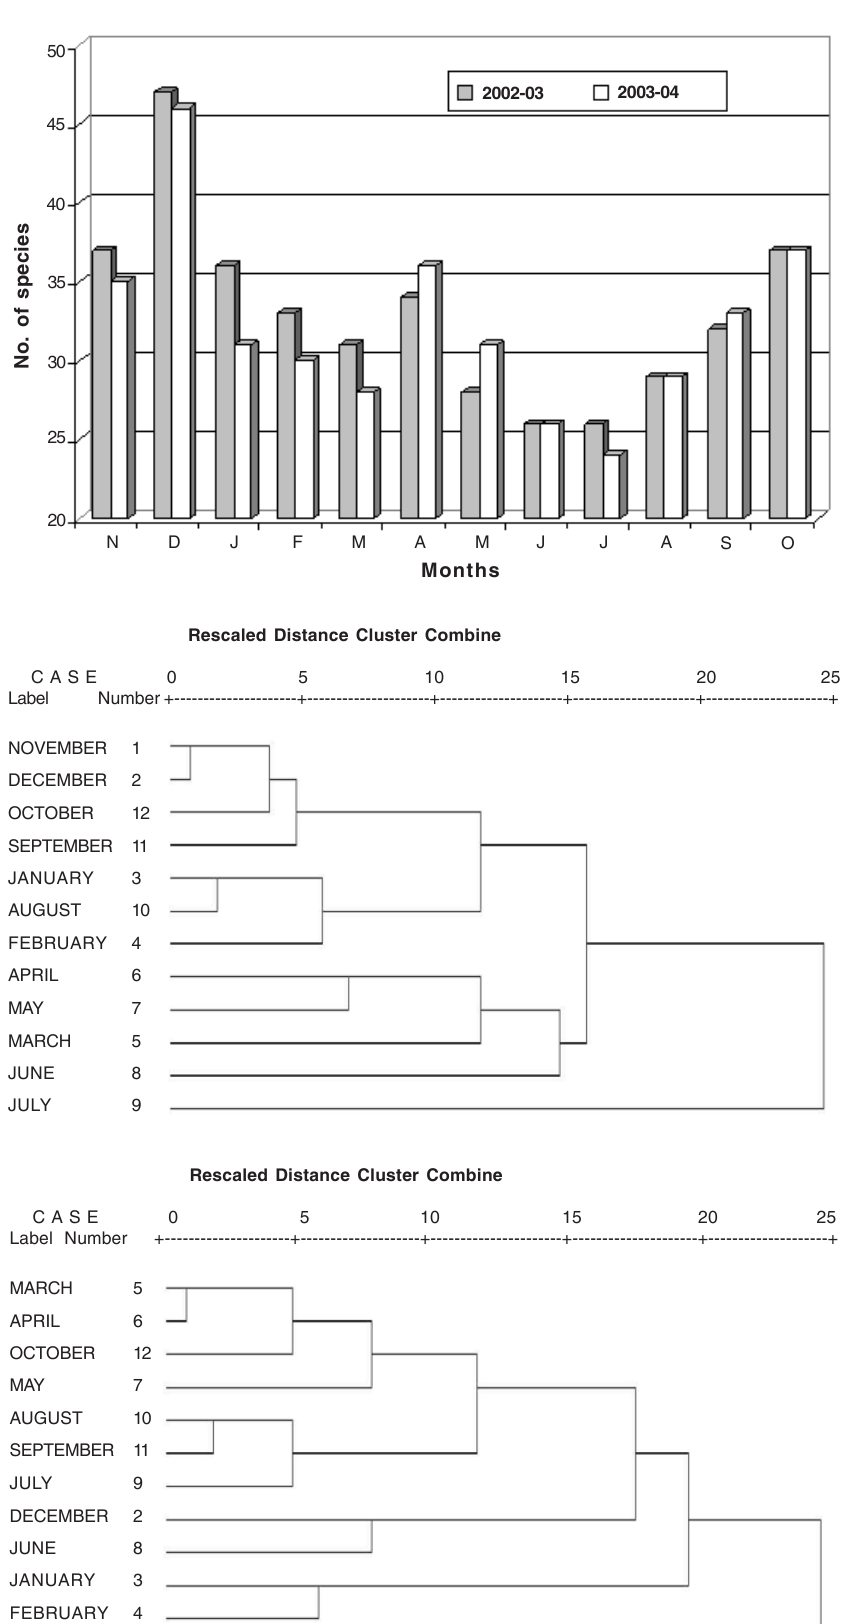
Figure 3. Hierarchical cluster analysis of microcrustacea